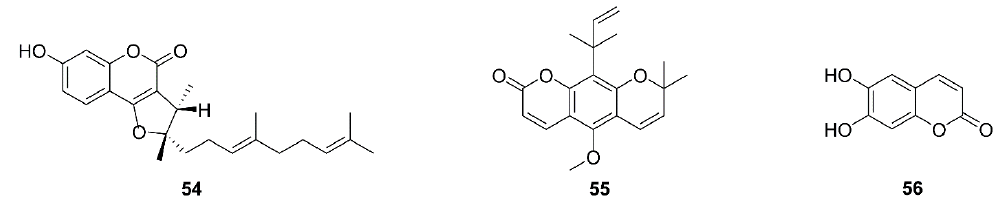
Figure 6. Chemical structures of coumarins ( 54 – 56 ).